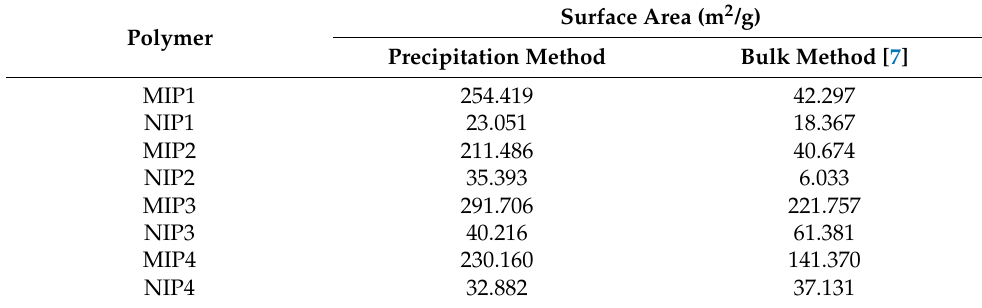
Table 4. Surface area of MIP and